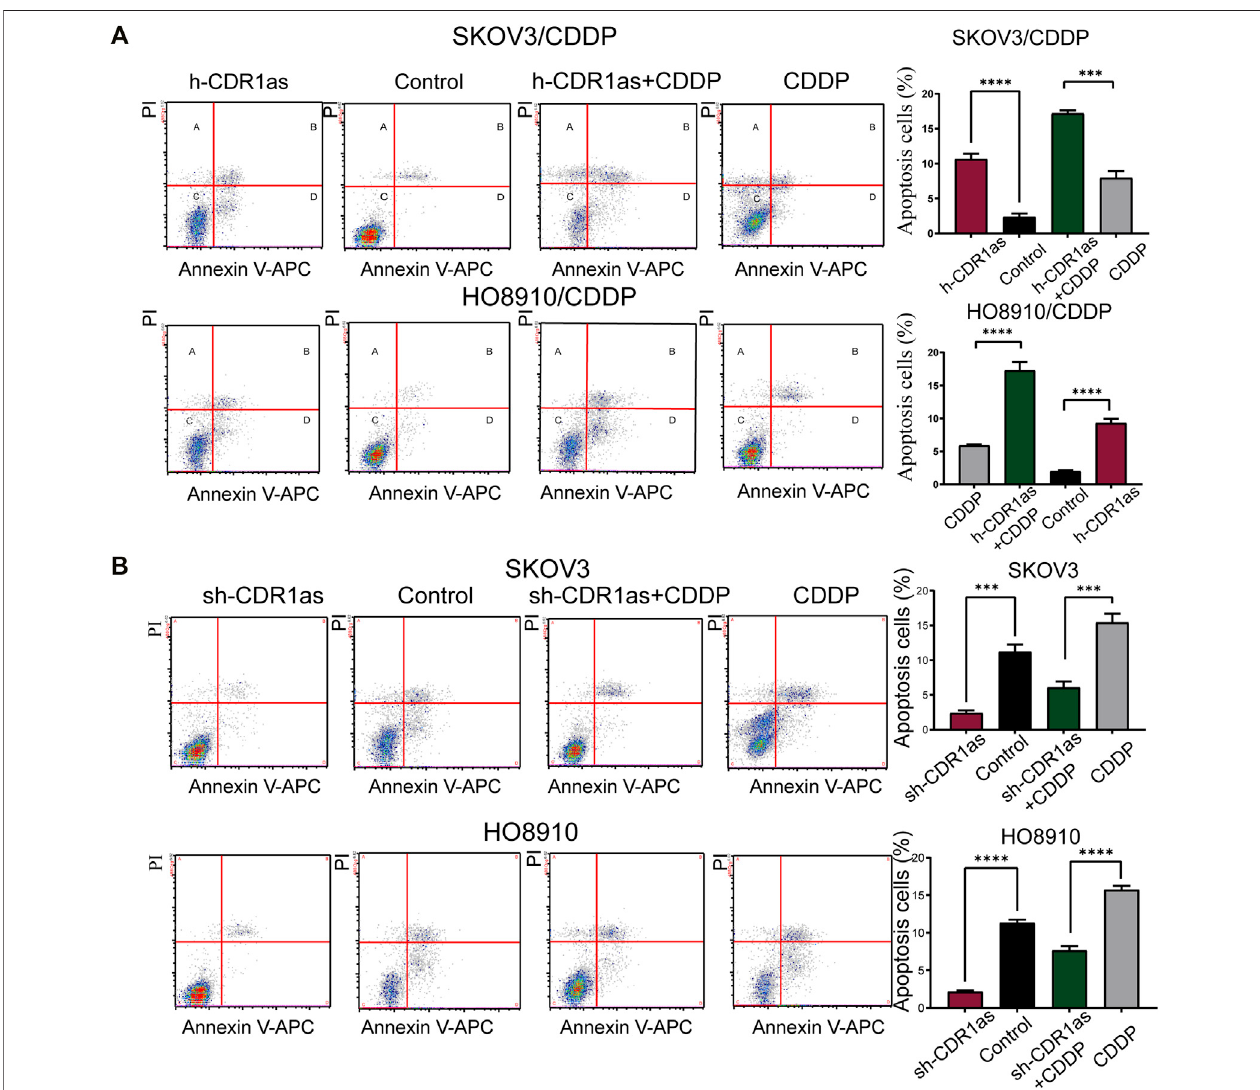
FIGURE 3 | CDR1as promotes the cell apoptosis. (A,B) The cell apoptosis rates of the CDDP-resistant and -sensitive OC cells transfected with CDR1as were determined by fl ow cytometric analysis. These results were presented as the mean ± SDs. *** p < 0.001 and **** p <